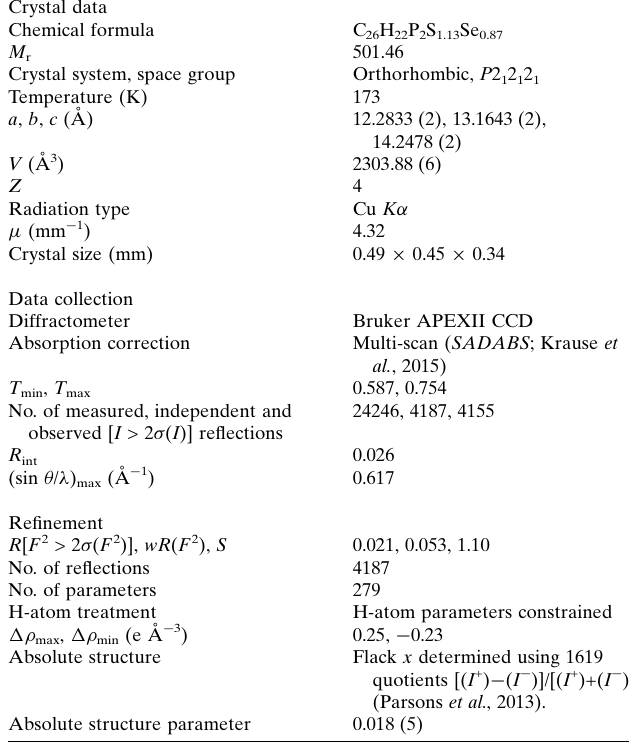
Table 5 C—H (cid:6)(cid:6)(cid:6) chalcogen close-contact geometry (A˚ , (cid:5) ). D —H (cid:6)(cid:6)(cid:6) A